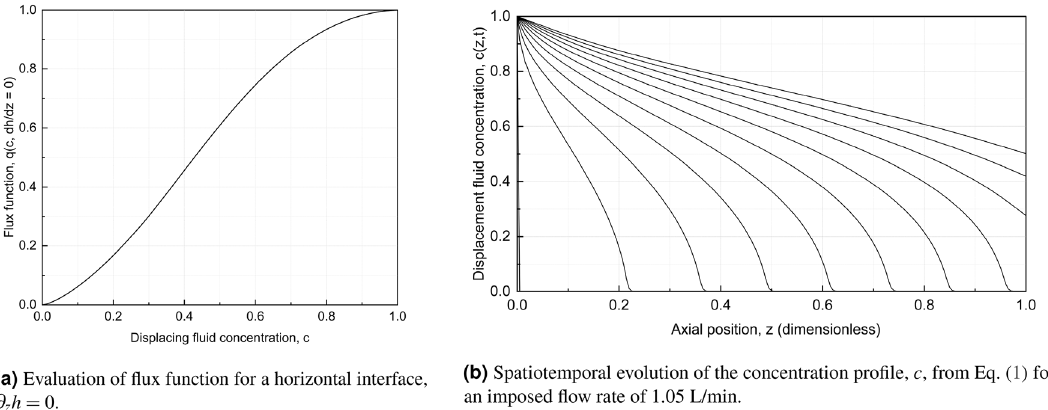
Figure 5. The spatiotemporal evolution of c is governed according to Eq. 1 by the flux function u H c . In ( a ) we plot the flux function normalized by the imposed velocity, q ( c , ∂ z h ) 0 . In ( b ), solutions of Eq. 1 for imposed flow rate corresponding to 1.05 L/min are horizontal interface, ∂ z h = shown as function of axial position normalized by the length of the pipe. The temporal separation of successive 0.08 L / U curves is � t ∗ =